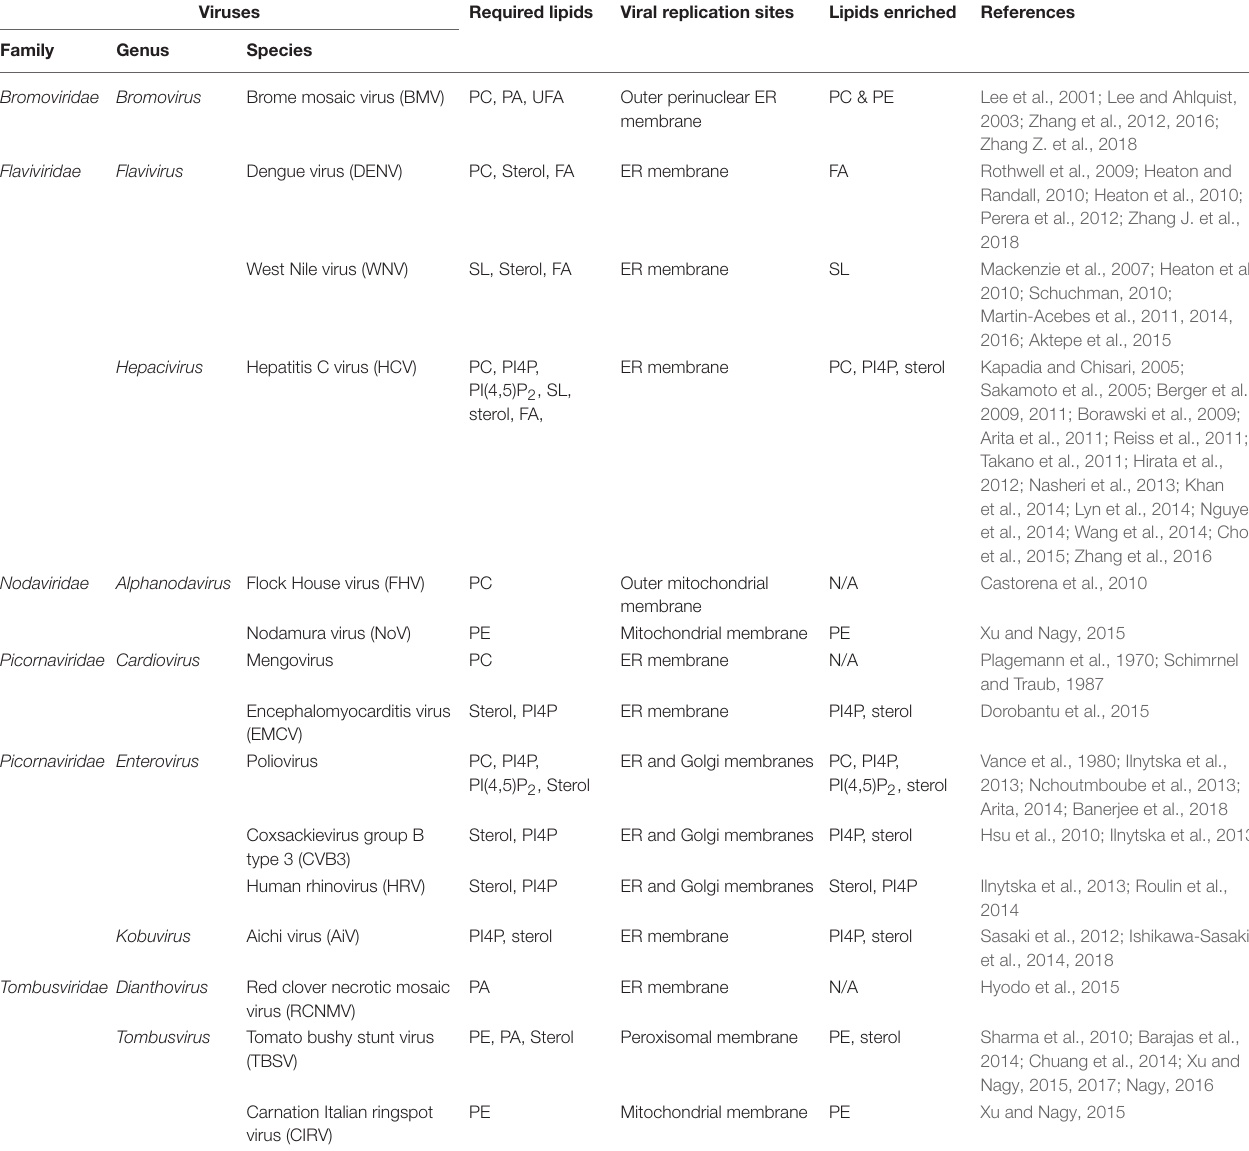
TABLE 1 | Specific lipid species required by different ( + )RNA viruses for successful genome